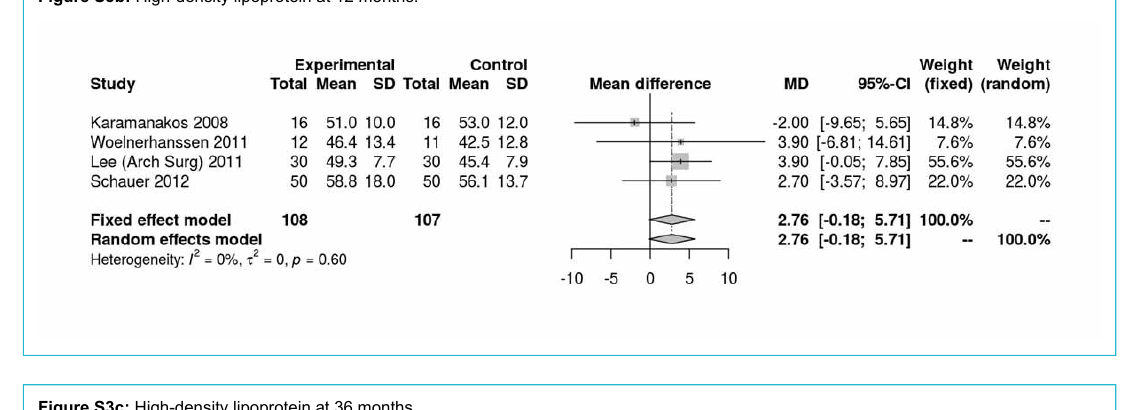
Figure S3b: High-density lipoprotein at 12 months.